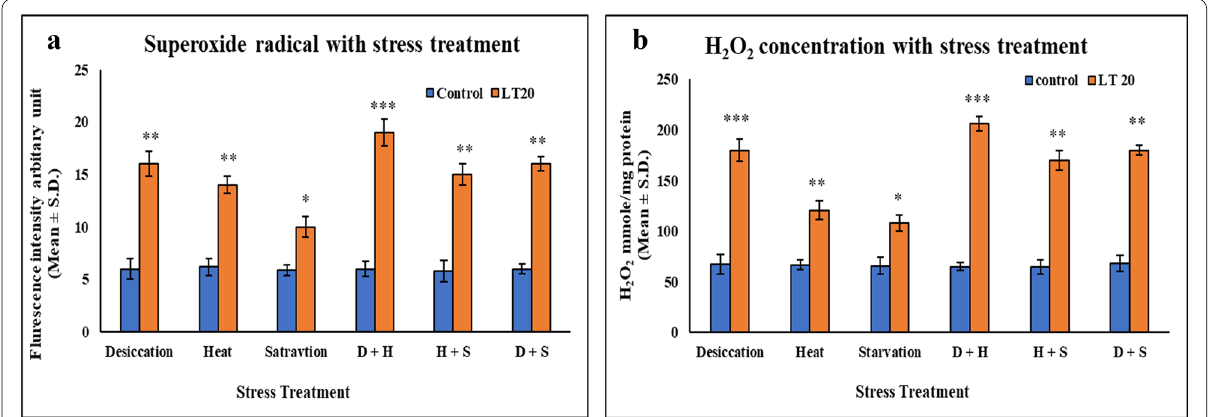
Fig. 2 Spectrofluorimetric measurement of ROS a superoxide radical expressed as level of arbitrary unit (mean peroxide (H 2 O 2 ) nmole/mg of protein (mean SD) in fourth instar larvae of C. ramosus . Values represent mean and the vertical bars represent SD. ± Data shown are representative of three independent experiments. ***P < 0.001; **P < 0.01; *P < 0.05 indicates level of